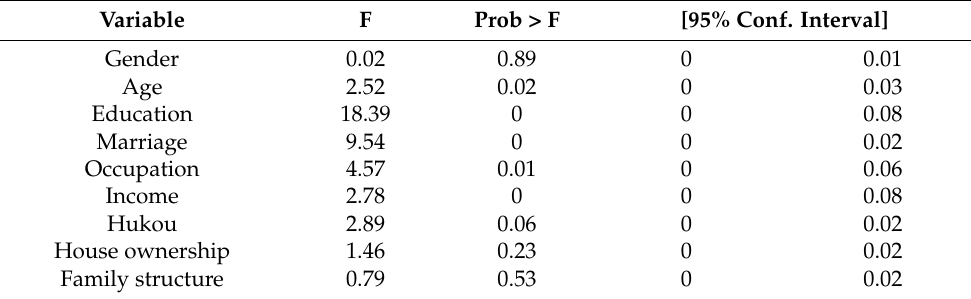
Table 6. Result of one-way ANOVA